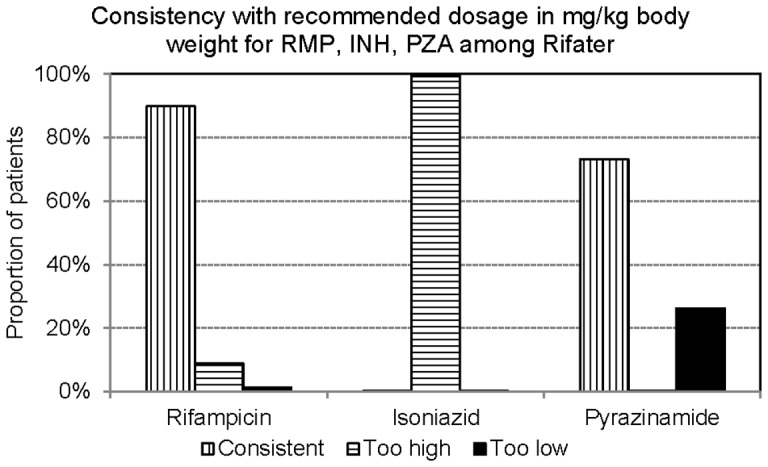
Consistency with recommended dosage in mg/kg body weight for Rifampicin 8–10 mg/kg), Isoniazid (4–6 mg/kg), and pyrazinamide (20–30 mg/kg) among those prescribed Rifater.